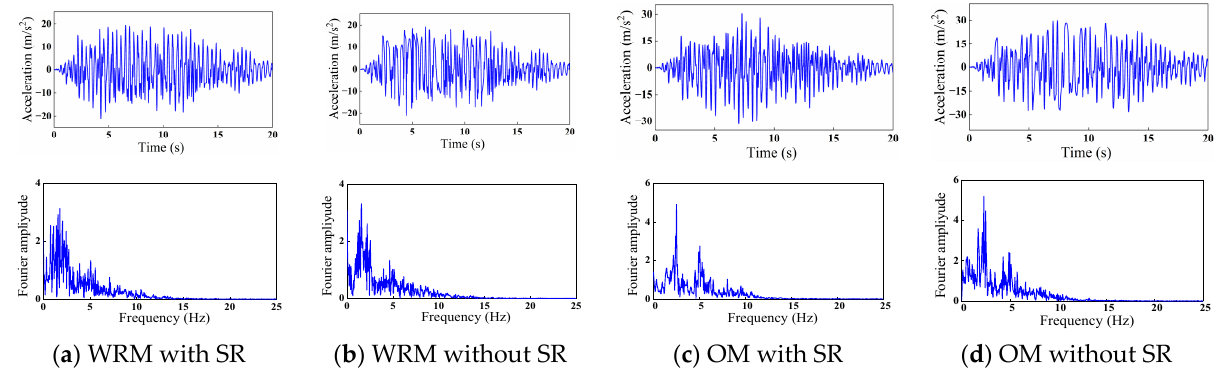
Figure 11. Response signals in the time and frequency domains at the top of the numerical model.